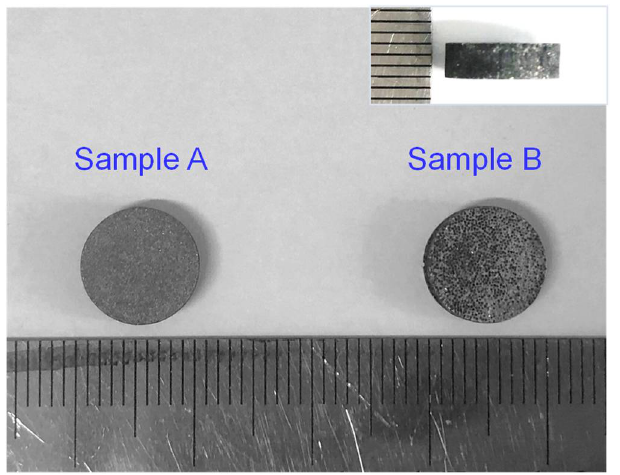
Figure 2. Optical images exhibiting the dimensions of the diamond/Al composite